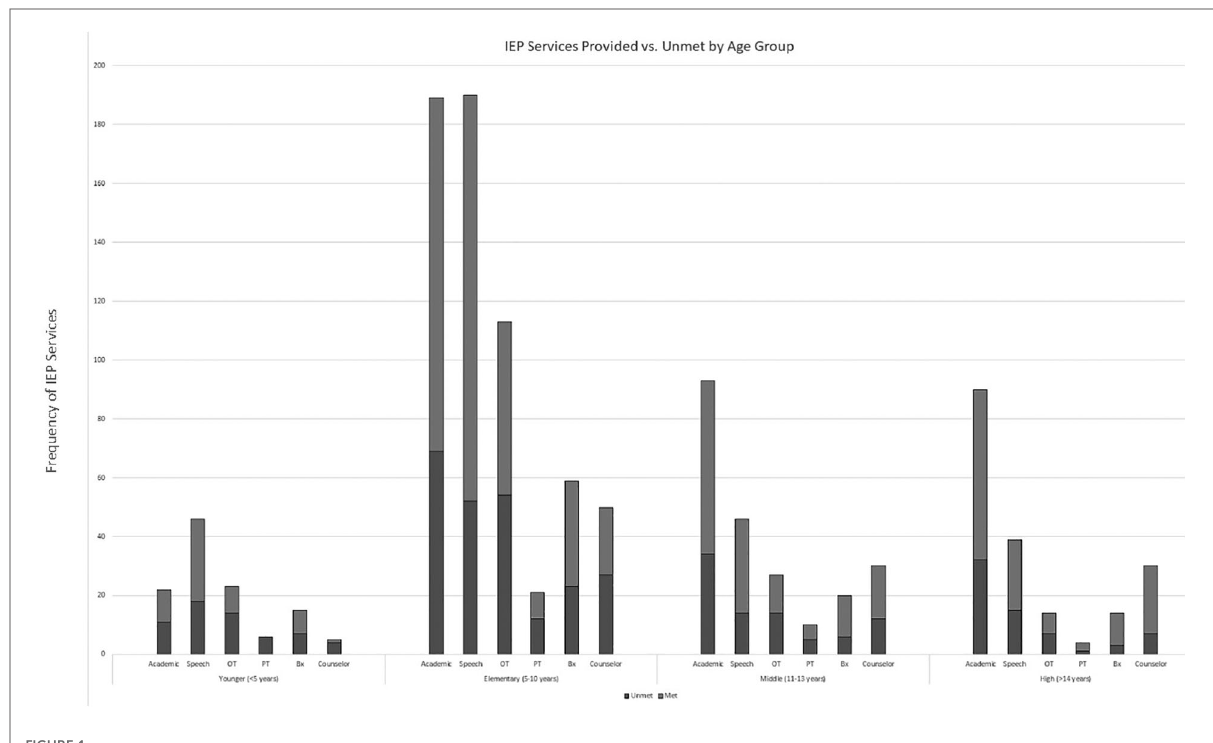
FIGURE 1 IEP services provided vs. unmet by age